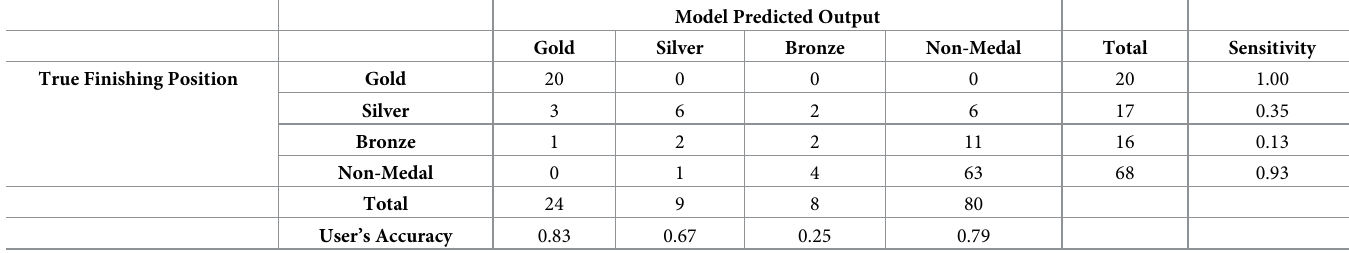
Table 2. RF1 misclassification matrix of medalling teams: Gold, Silver, Bronze; and non-medalling teams.